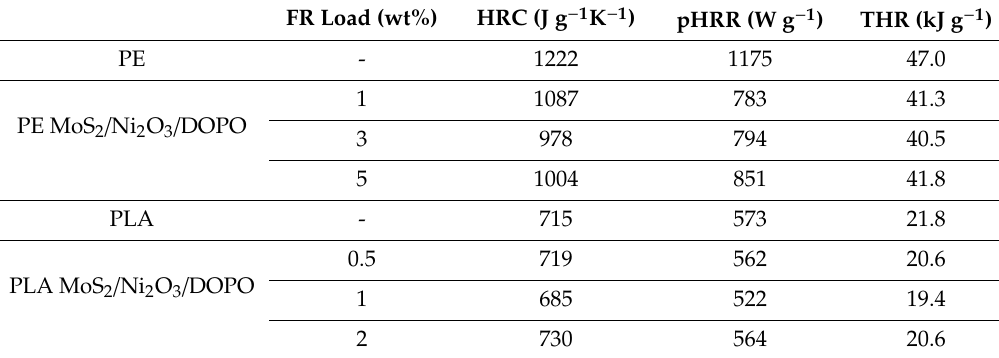
Figure 7. Examples of heat release rate (HRR) curves obtained for PE ( A ) and PLA ( B ) composites compared to pristine polymers. Table 2. Microscale combustion calorimetry (MCC) combustion data of PE and PLA composites compared to pristine